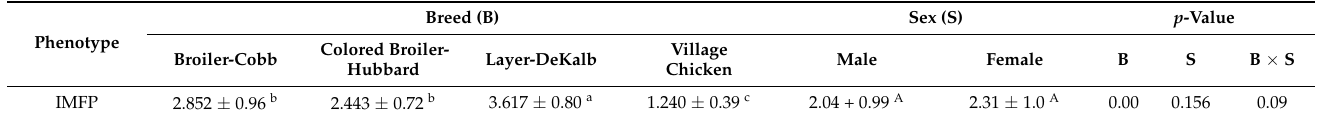
Table 3. Effect of breed and sex on intramuscular fat percentage of breast muscle in four chicken breeds in Malaysia. Breed (B) Sex (S) p -Value Phenotype Broiler-Cobb Colored Broiler- Hubbard Layer-DeKalb Village Chicken Male